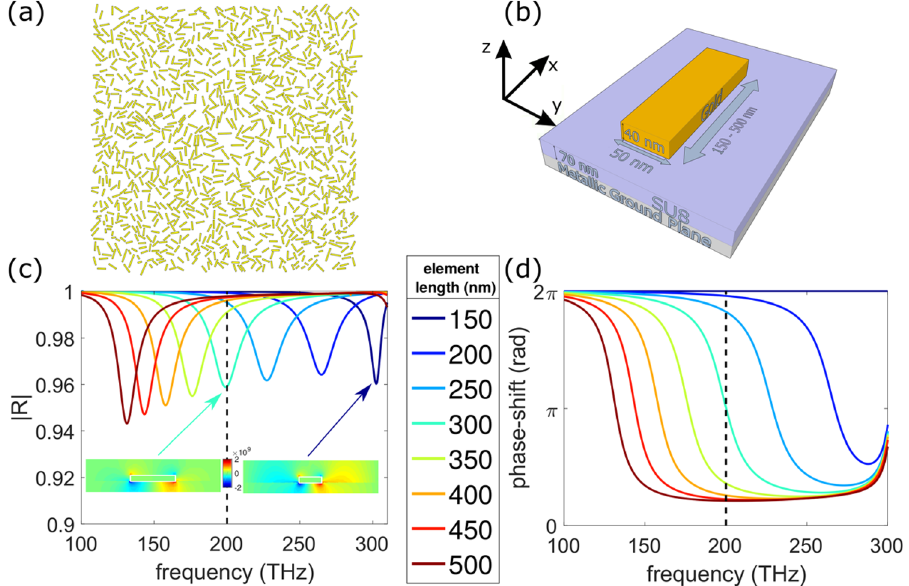
Figure 1. ( a ) Random metalens made of gold anisotropic scatterers. ( b ) Phase-shifting element (nano- resonator) of the metasurface. The element dimensions are 50 nm width, 40 nm height, with a length varying from 150 nm to 500 nm. The dielectric spacer, SU8, has a thickness of 70 nm and is on a metallic ground plane. ( c ) Amplitude of the reflection coefficient as a function of the frequency around 200 THz and for elements length from 150 nm to 500 nm. Vertical dashes mark the 200 THz frequency. p x = 900 nm and p y = 100 nm. Insert: Electric field (z component) in the plane (y = 0 nm) of the 150 nm at 300 THz and the 300 nm element at 200 THz. ( d ) Same as ( c ) for the phase-shift of the reflection